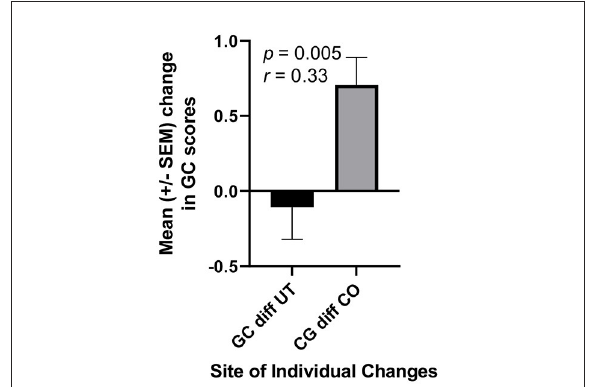
FIGURE5 The changes in students GC scores in CO significantly exceeded those in UT. Each student’s score in August was subtracted from their score in December, and the resultant series of differences (diff) in CO ( n = 42) and UT ( n = 30) were compared statistically using an unpaired t -test.